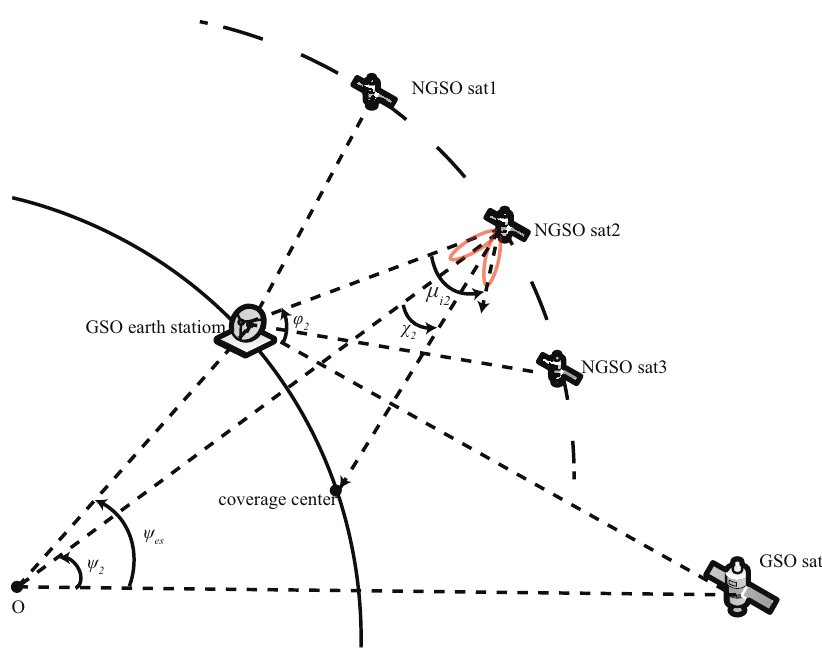
Figure A1. The interference scenario between the NGSO system and the GSO